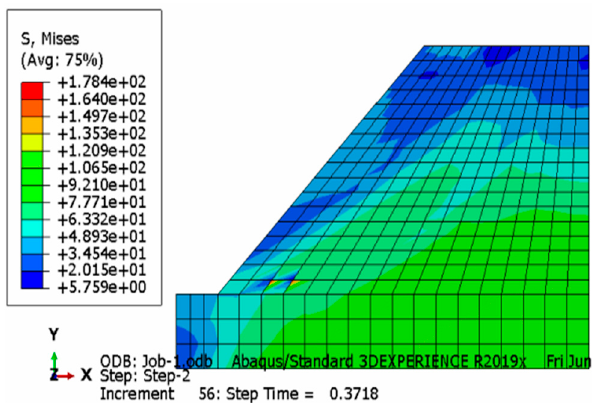
Figure 11. Stress cloud diagram of slope instability at room temperature .